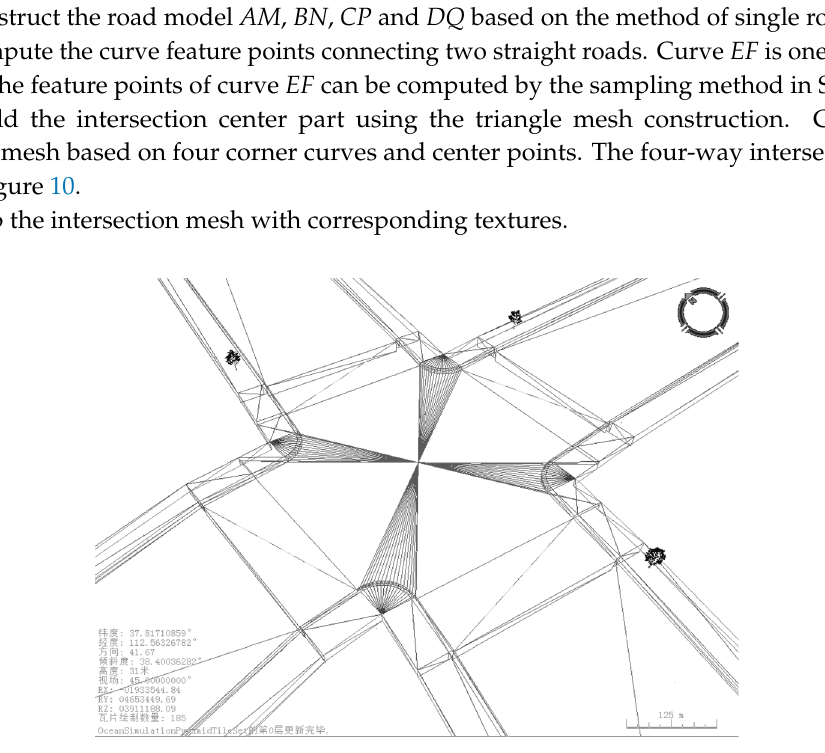
Figure 10. Mesh structure for the four-way